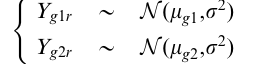
Figure 2 represents PCAs and dendrograms resulting from gene list analysis. The cumulative inertia explained by the two first axes of PCA is about 80% . Both representations underline the same tendencies.